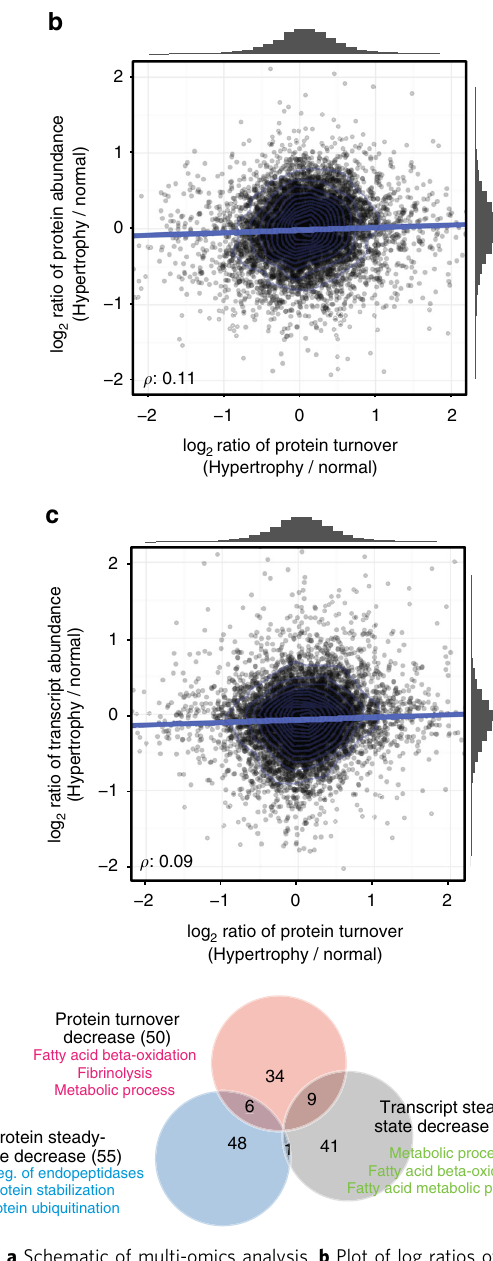
protein turnover and 50 with decreased protein turnover; 61 with increased protein abundance and 55 with decreased protein at transcript and protein levels would be expected. Instead, we